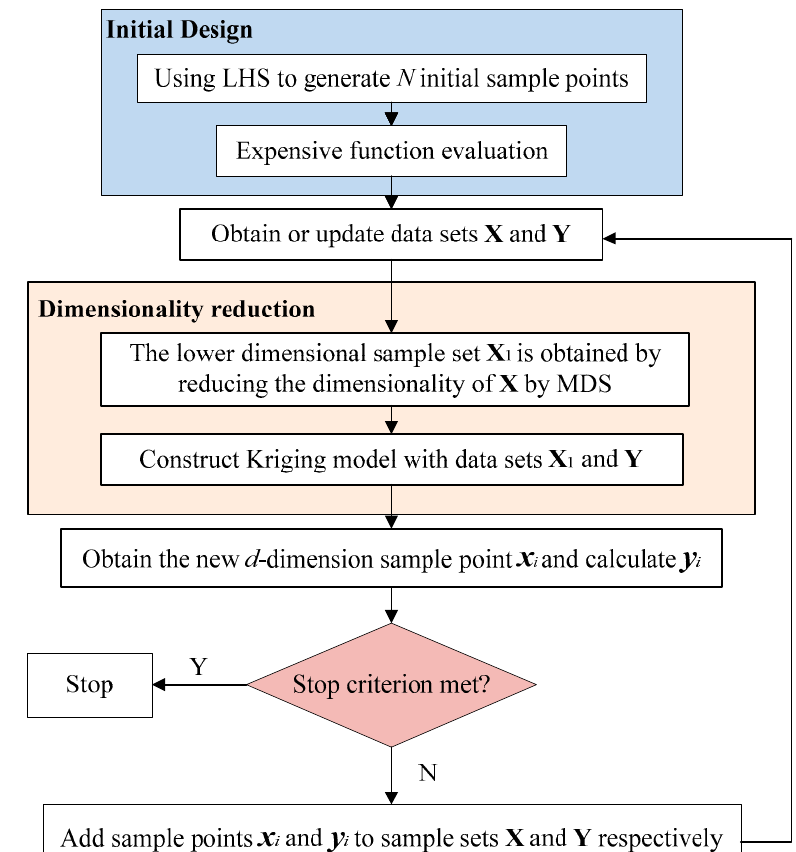
Figure 3. Flowchart of the KMDS